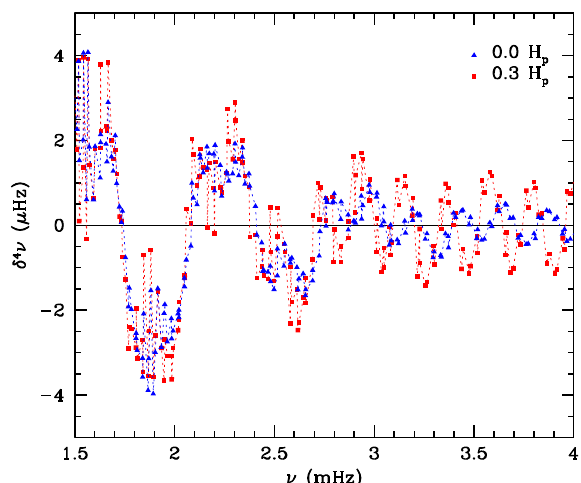
Fig. 18 The signature of the acoustic glitches in two solar models, one without overshoot ( blue triangles ) and one with an overshoot of 0 . 3 H p ( red squares ). The signature has been enhanced by taking the fourth differences of the frequencies. Dotted lines joining the points are meant merely to guide the eye, the jaggedness of the lines reflects the (cid:2) -dependence of the signature. Note that there are two distinct oscillatory patterns, the larger-wavelength one is the signature of the He ii ionisation zone, the smaller wavelength one is from the base of the convection zone. Note that the amplitude of the smaller-wavelength pattern is larger for the model with